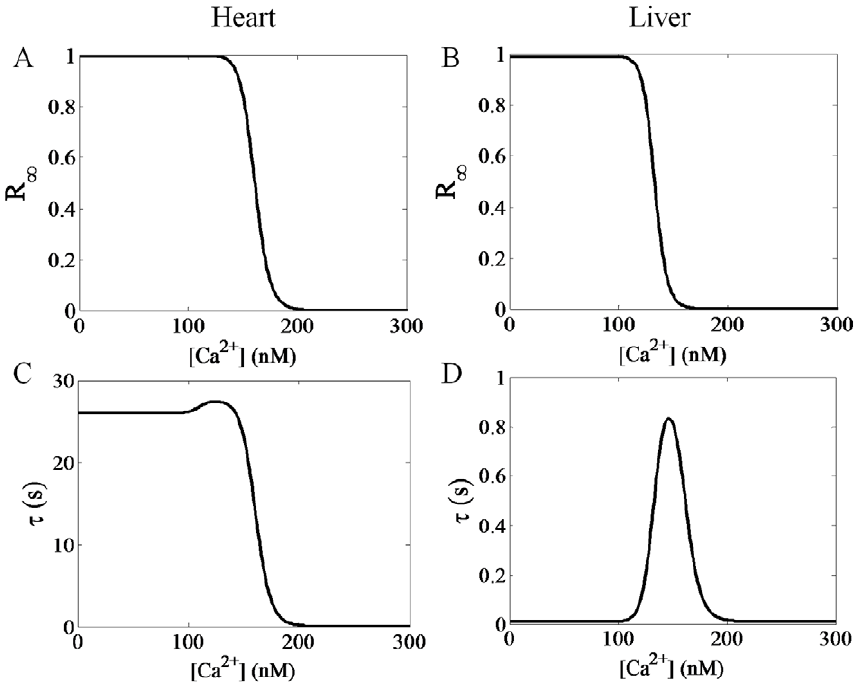
Figure 4. The steady state values for state R and time constants for the models as a function of Ca 2 + is presented for heart and liver RaM. Although the steady state values for state R (A and B) are identical, the time constants (C and D) are dramatically different between heart and liver RaM.